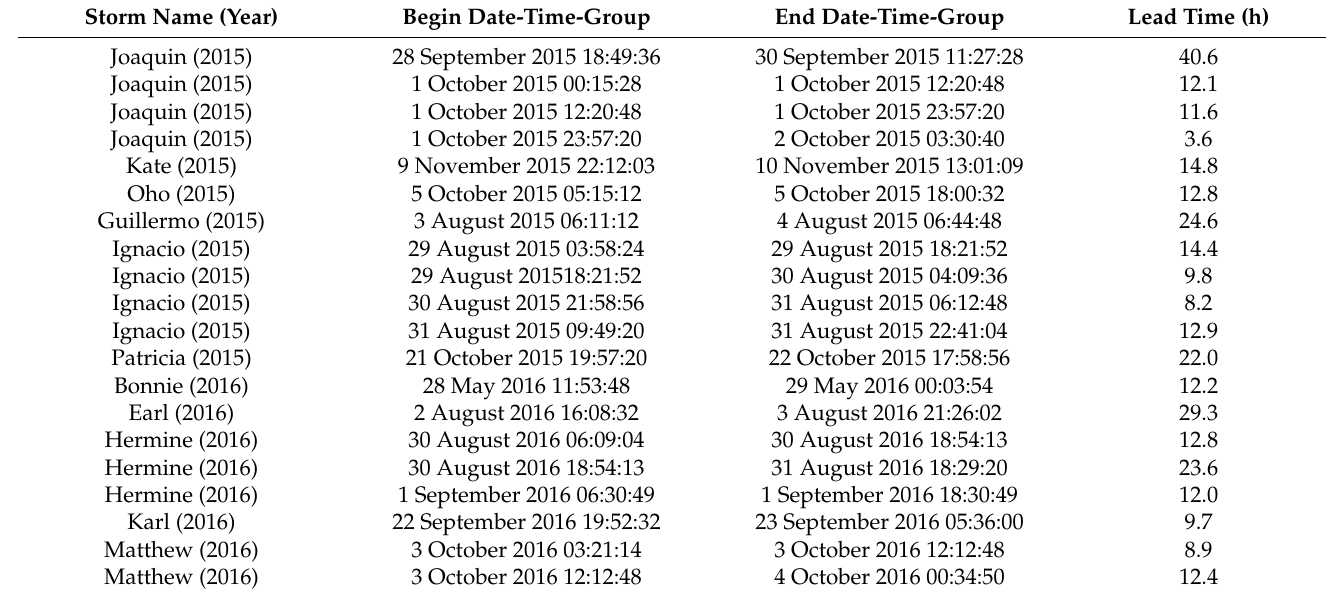
Table 1. Real cases used for baseline testing of SWAMI. The storm name, initialization date-time-group, verifying (end) date-time-group, and forecast length are